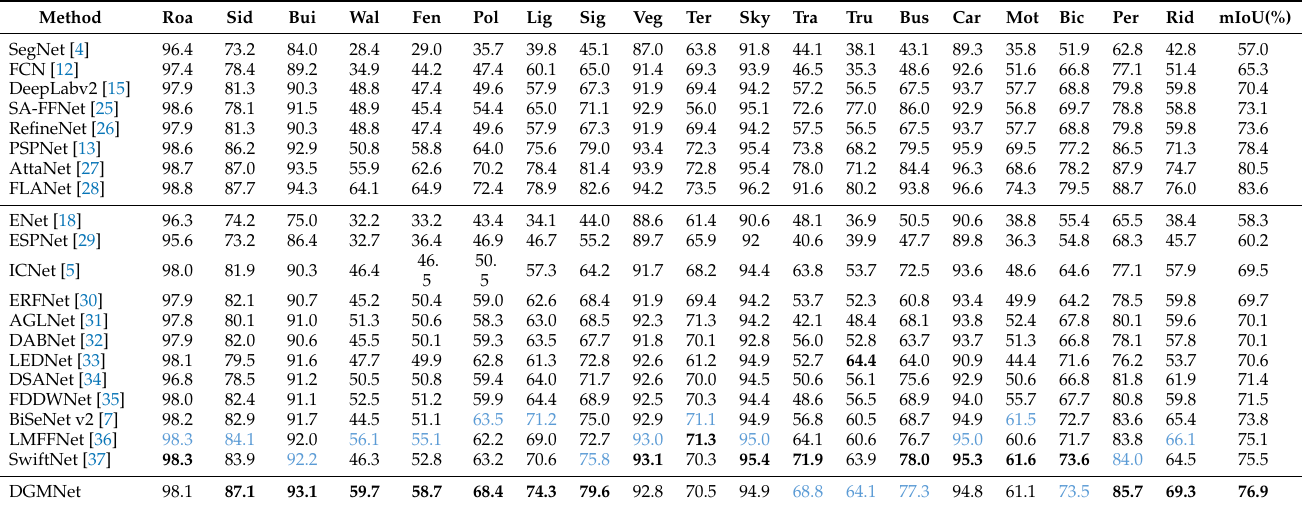
Table 3. Comparison of IoU values and mIoU for 19 categories of different methods on the Cityscapes test dataset. The highest IoU for each class is highlighted in bold, and the next highest IoU is highlighted in blue.